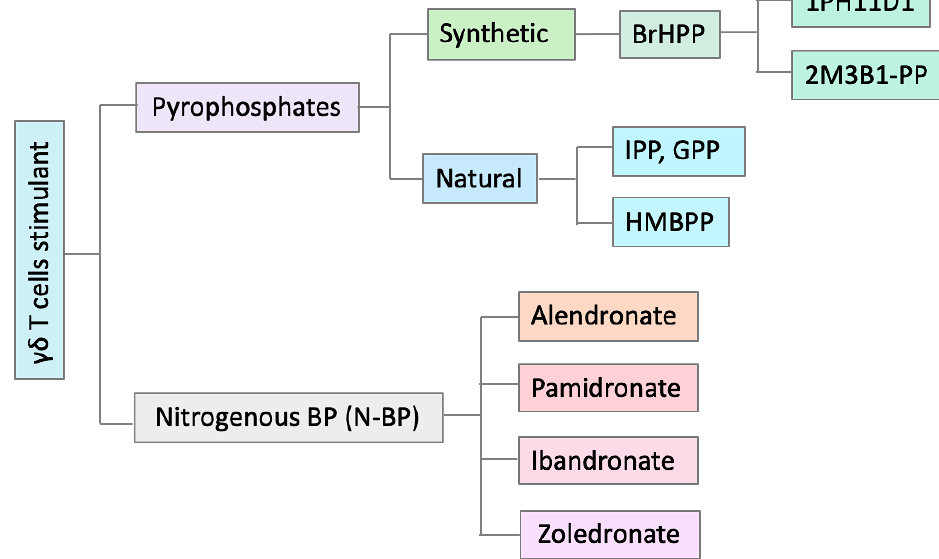
Figure 2. Various phosphoantigen and bisphosphonate compounds. Some of the most important pAgs and BPs mentioned in the text are shown here. BPs are a class of chemical compounds with two PO 3 (phosphonate) groups that are widely used to treat osteoporosis (the condition of low bone density). Zoledronate is one of the most potent N-BPs that have been widely used for in vitro and in vivo expansion of V δ 2 γδ T cells. (E)-4-hydroxy-3-methyl-but-2-enyl pyrophosphate (HMBPP) is an essential metabolite in most pathogens including mycobacterium tuberculosis and malaria. Isopentenyl pyrophosphate (IPP) and geranyl pyrophosphate (GPP) are the intermediate metabolites in the isoprenoid biosynthesis pathways. Bromohydrin pyrophosphate (BrHPP) is a synthetic alkyl diphosphate pAg. Pyrophosphates such as IPP and GPP are able to directly stimulate V δ 2 γδ T cells, while BPs act indirectly via blocking the FPPS enzyme in isoprenoid biosynthesis pathways which results in IPP and GPP accumulation in the cells (see Figure